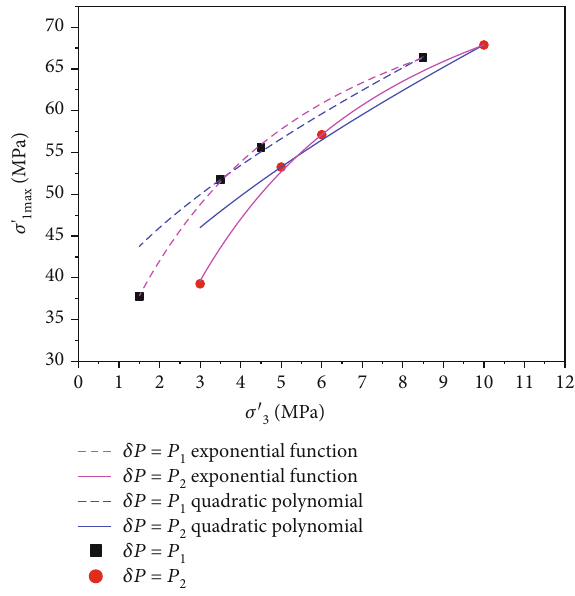
Figure 8: Triaxial compression strengths of DT coal samples and fi tting curves of two strength criteria under seepage